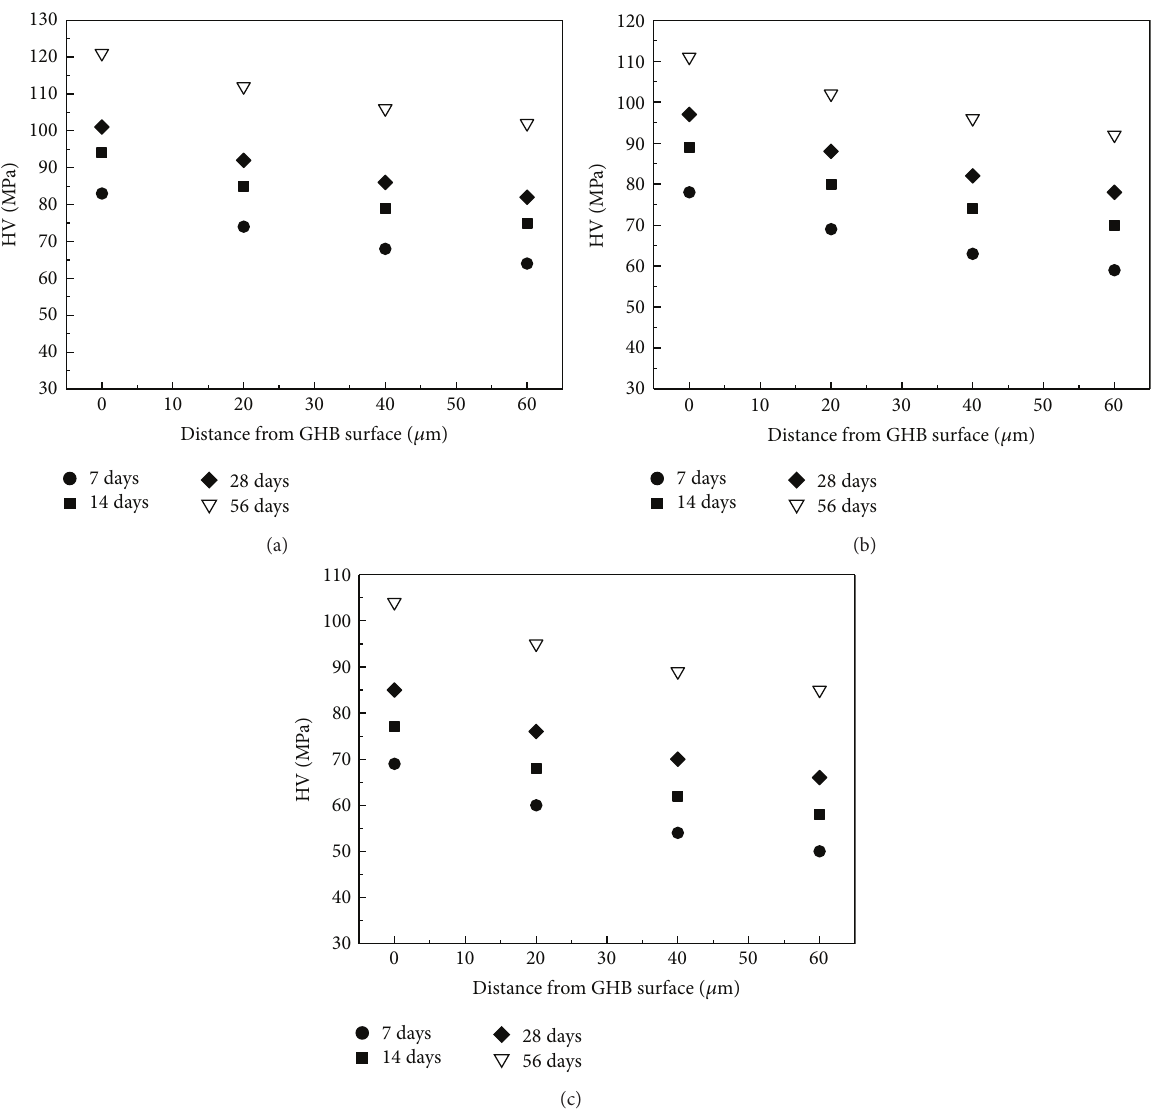
Figure 12: The influence of age of curing on the interfacial HV of cement paste at different water to cement ratios ((a) for 0.45, (b) for 0.5, and (c) for